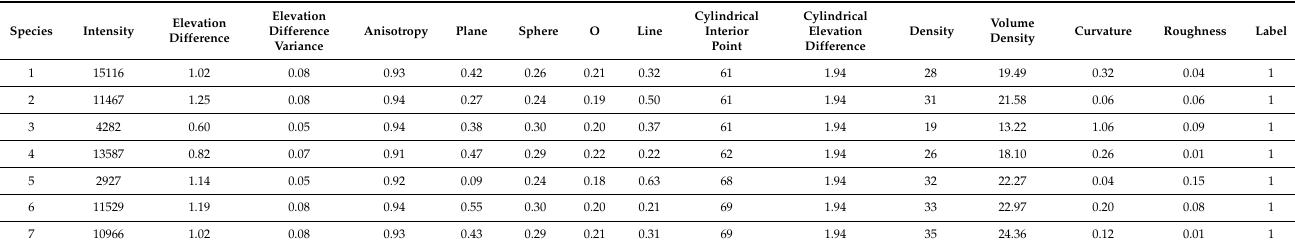
Table 1. The feature vectors. There are 14 kinds of feature vectors representing different types in horizontal direction. The last column represents the label values. Only seven of these datasets are shown in the table.